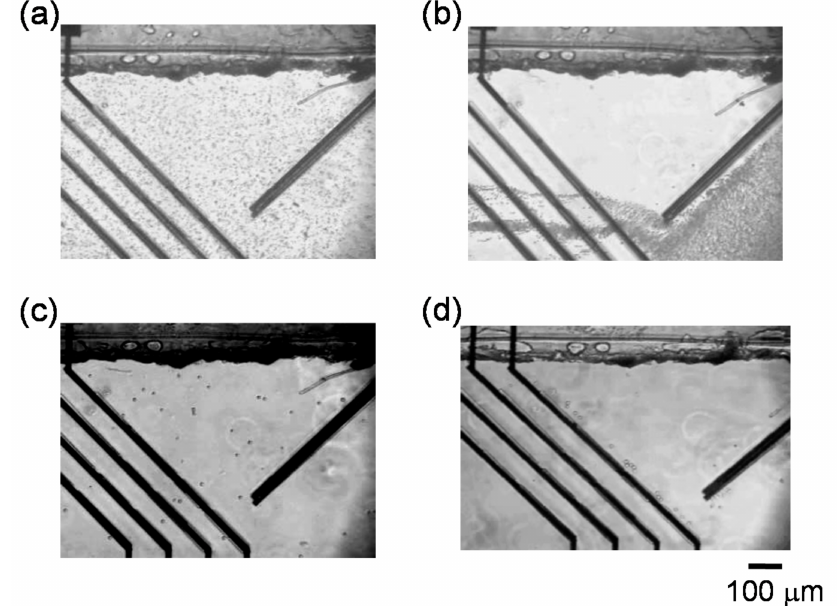
Figure 3. Red blood cells (RBCs) flowing in the channel under negative dielectrophoresis (n-DEP) ( a ) before and ( b ) after applying AC voltage to both navigate electrodes and separate electrodes (i) and (iii). Human acute monocytic leukemia cell line (THP-1 cells) flowing in the channel ( c ) before and ( d ) after applying AC voltage.